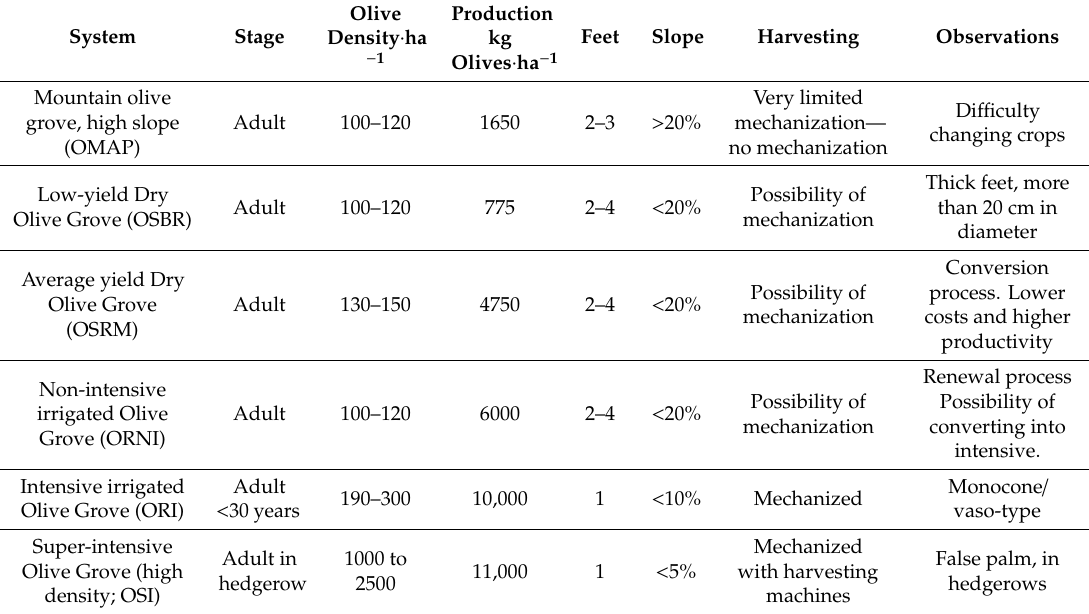
Table 1. Olive cultivation systems [44,45,48].